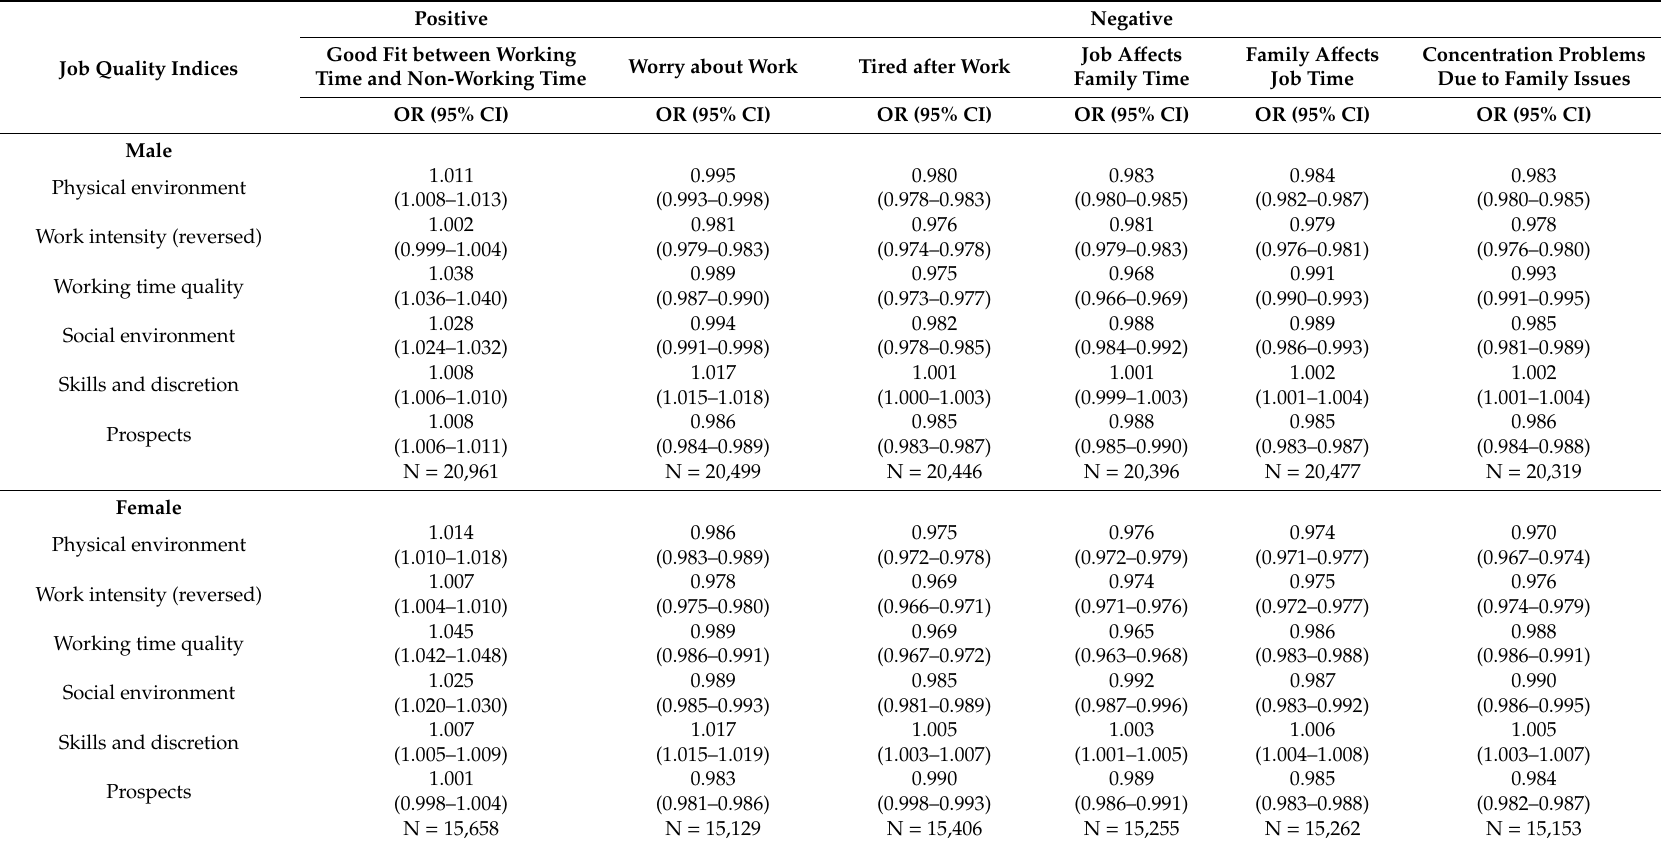
Table 4. Association between job quality indices and work–life balance by